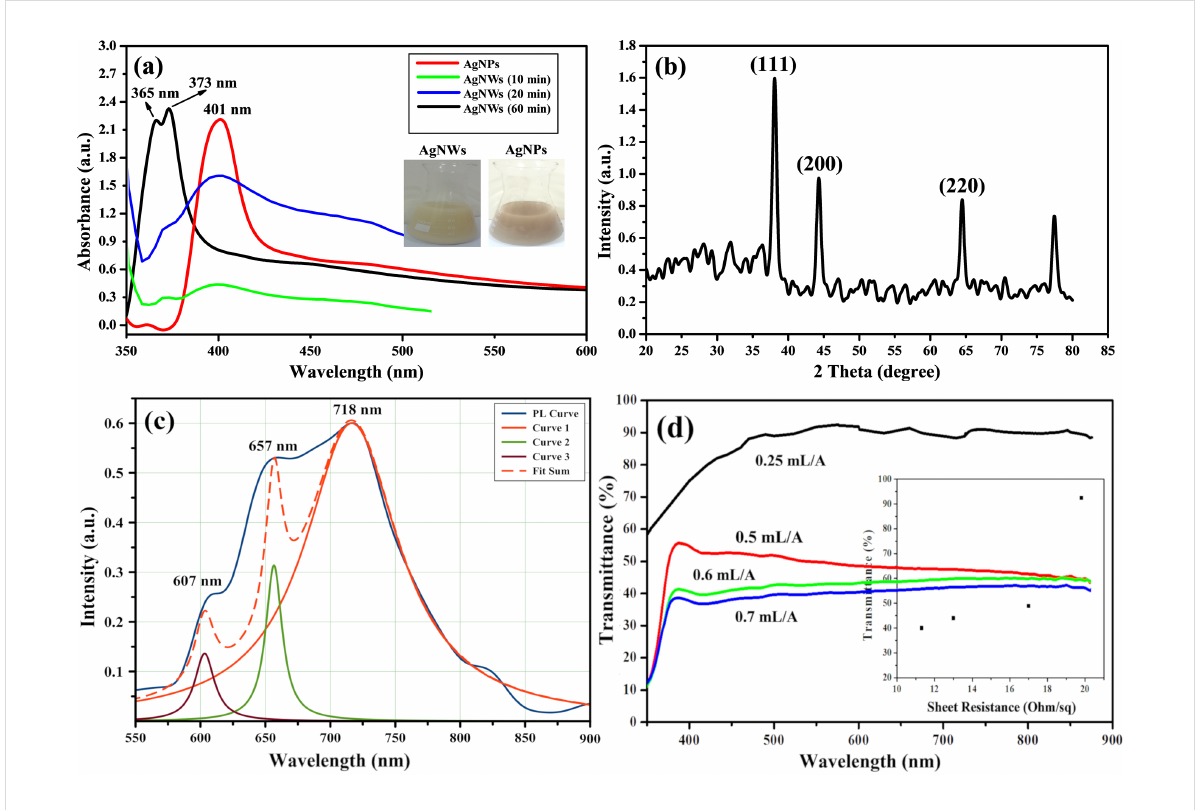
Figure 3: (a) UV–vis absorption spectra indicating the formation of AgNPs just after complete addition of AgNO 3 (red line) and the end of the reaction with the formation of AgNWs (black line). The spectra after 10 min (green line) and 20 min (blue line) are also given. The insets showing the actual solution colors. (b) XRD pattern of the as-synthesized AgNWs sample. (c) PL emission spectrum of AgNWs falling in the range of 600–800 nm with red emission. The de-convolution into Lorentzian peaks yields peaks at 607, 657, and 718 nm. The red dashed curve is the fit sum of all three Lorentzian peaks. (d) Transmittance-vs-wavelength plot of AgNW-coated PET films with different densities (corresponding to the quantity of AgNW- based dispersion ink, i.e., 0.25, 0.5, 0.6, and 0.7 mL per unit area A of the film of 5 × 5 cm 2 ) and the inset shows the transmittance-vs-sheet resis- tance plot of the fabricated PET film